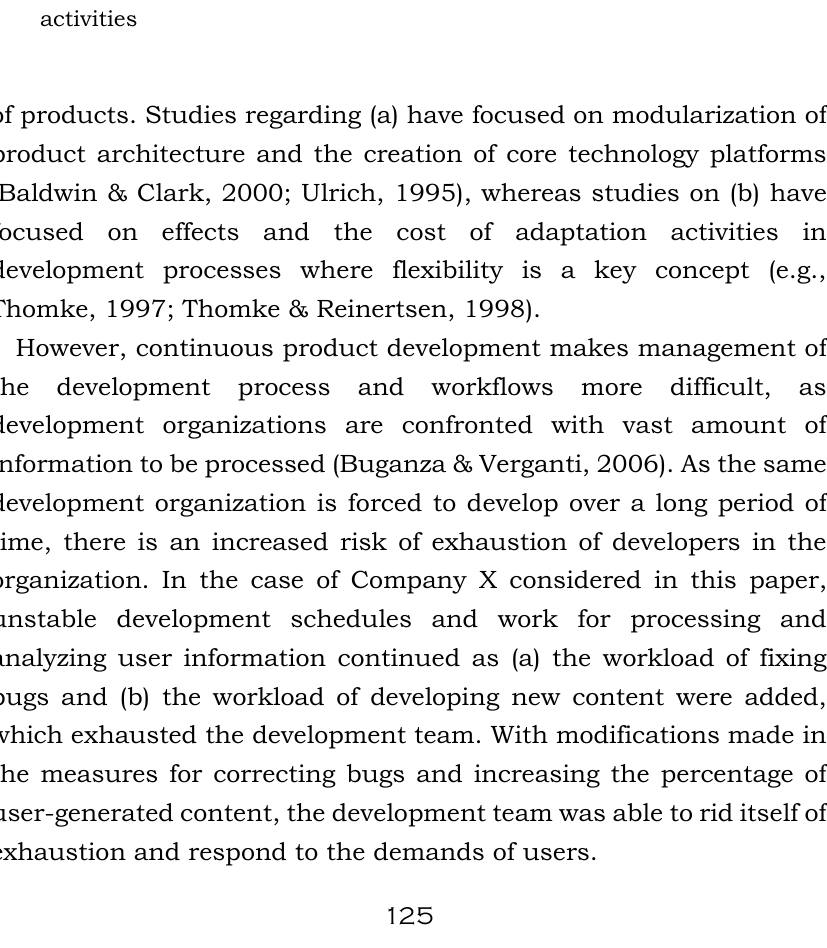
Figure 1. Comparison of traditional and continuous development